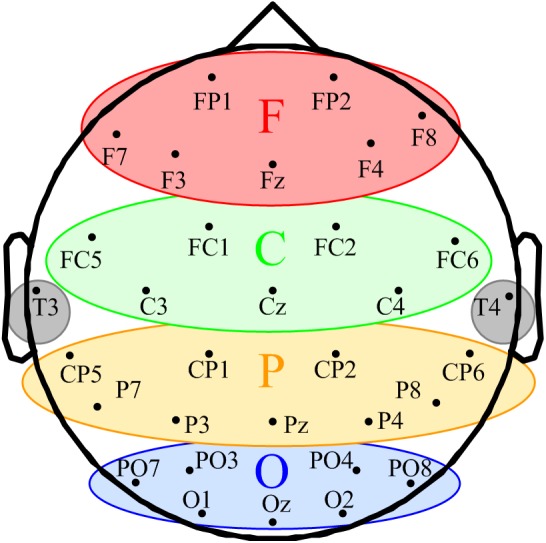
Schematic of space participation of five regions for 32-channel EEG. The seven channels in the red ellipse constituted the frontal region (F). The seven channels in the green ellipse were divided into the central region (C). The yellow ellipse comprised nine channels represents the parietal region (P). The blue ellipse comprised nine channels represents the occipital region (O). T3 and T4 in the gray circles were classified into the temporal region.